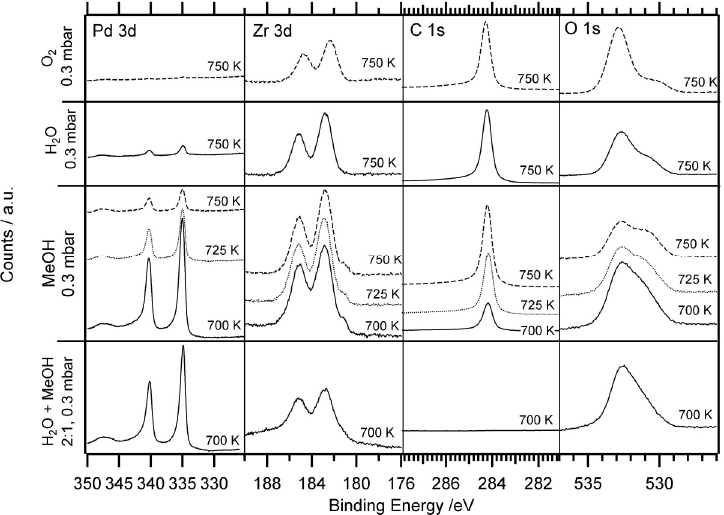
Figure 1. In situ near-ambient pressure X-ray photoelectron (NAP-XP) spectra (Pd 3d, Zr 3d, C 1s and O 1s (overlapping with Pd 3p) regions) of CVD-grown 0.5 ML ZrO x H y on a Pd model catalyst